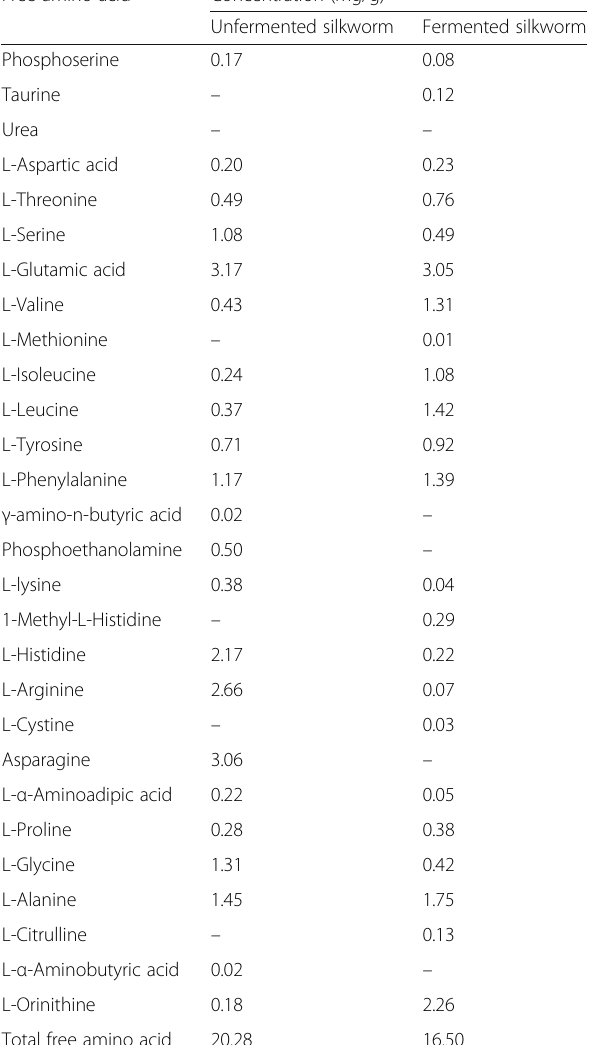
Table 1 Fatty acid content of unfermented, and fermented silkworm. (Unit: mg/g)